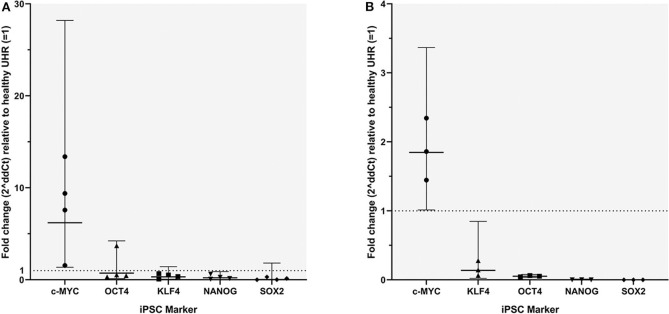
Graph showing 2ΔΔCT values of RT-qPCR runs performed on four snap-frozen metastatic head and neck cutaneous squamous cell carcinoma (mHNcSCC) tissue samples (A) and four mHNcSCC-derived primary cell lines (B), amplifying transcripts for OCT4, NANOG, SOX2, KLF4, and c-MYC. ΔΔCT was calculated by normalizing CT values of iPSC markers to that of the housekeeping genes GAPDH and PUM1, and then expressing this relative to the ΔCT of normal UHR. Error bars: 95% confidence interval.